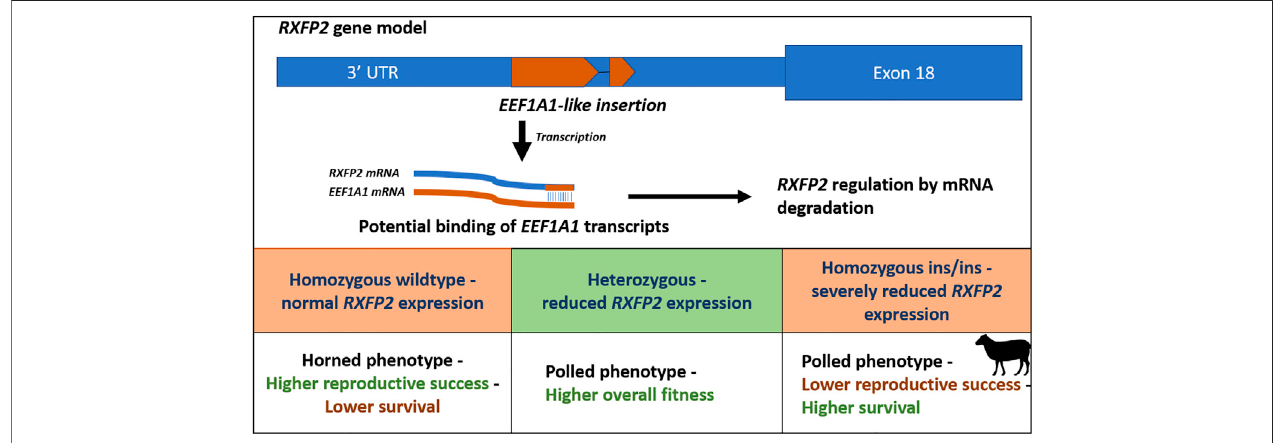
FIGURE 2 | Schematic overview of the polledness trait in Soay sheep (Johnston et al., 2013; Wiedemar and Drögemüller, 2015). The polledness phenotype is associated with a EEF1A1 -like insertion in the 3 ′ UTR of the RXFP2 gene. The insertion potentially leads to RXFP2 post transcriptional regulation by binding EEF1A1 transcripts (caused by double stranded RNA degradation). Homozygous wildtype sheep have horns and higher reproductive success but lower survival, whereas homozygous ins/ins sheep exhibit lower reproductive success but higher survival. Heterozygotes exhibit the highest overall fi tness underlying balancing selection.